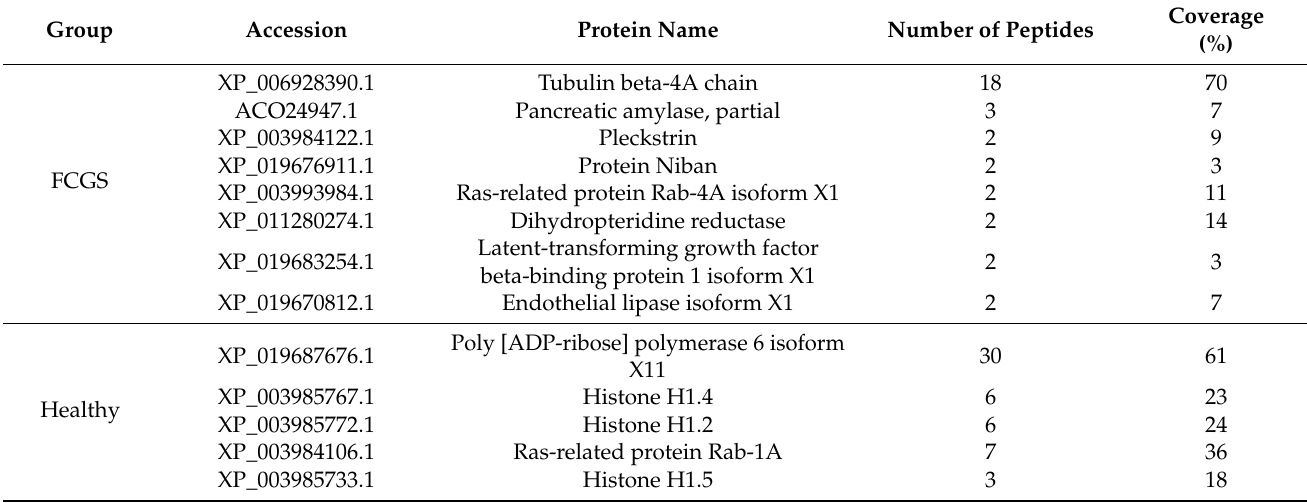
Table 3. Proteins exclusive to the exosomes of a certain group. A total of eight proteins were only identified in the exosomal proteome within the FCGS group and five proteins were exclusively found in the exosomes of the healthy donors. Group Accession Protein Name Number of Peptides